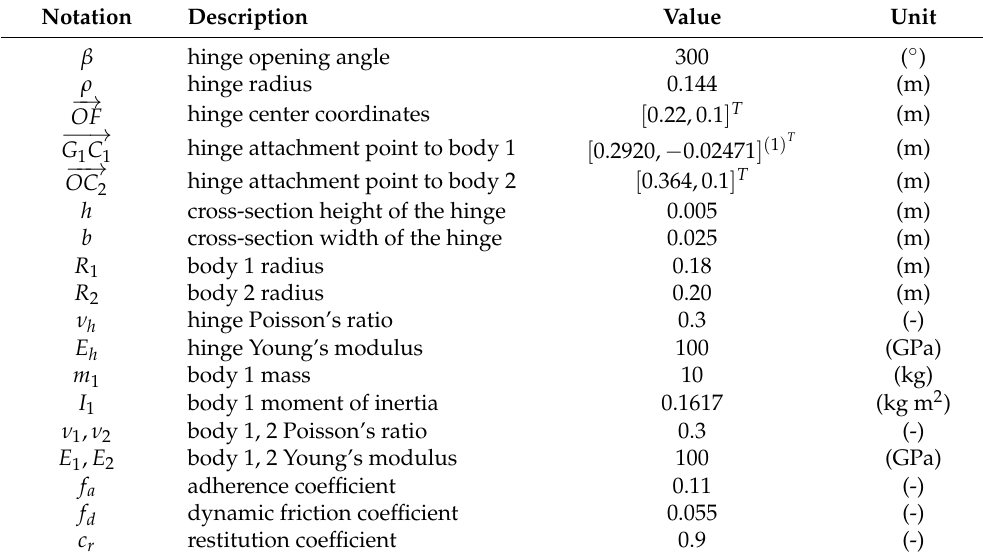
Figure 4. Layout of the CSFH used in the numerical simulations. Initial undeformed configuration. Table 1. Common geometric, inertial, and structural parameters of the CSFH used in the numerical